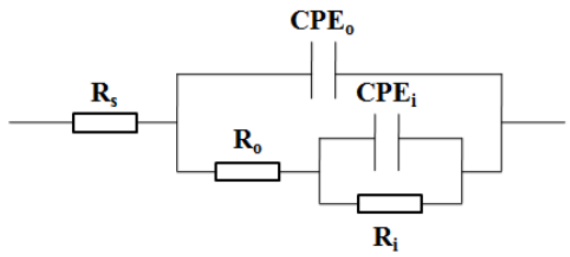
Figure 11. EEC model for EIS interpretation.